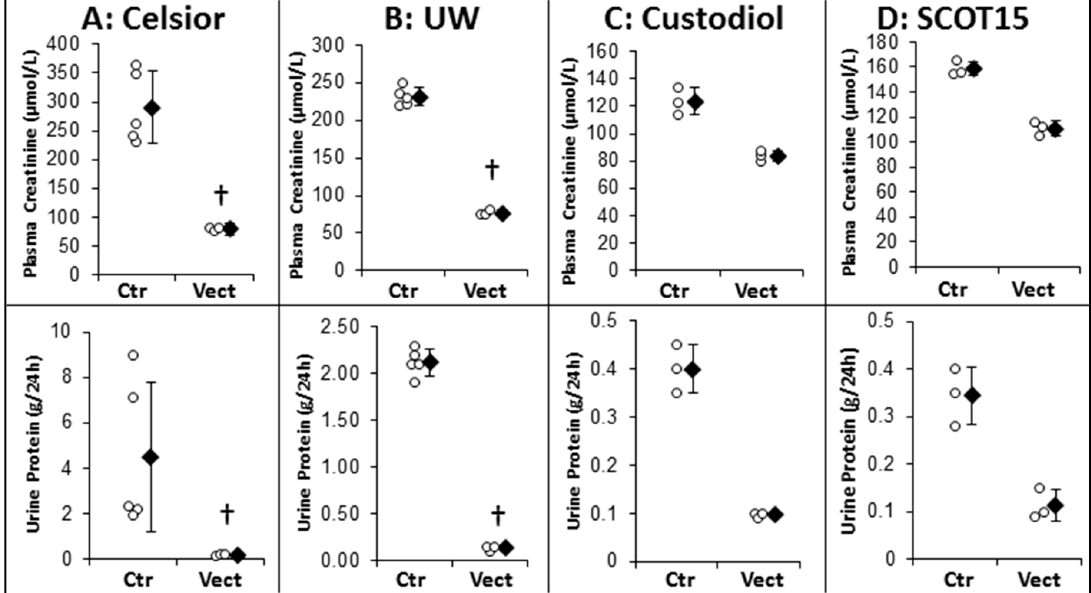
Figure 3. Evaluation of Vectisol ® benefits during static preservation: late follow-up. Vectisol was used to supplement preservation solutions in a porcine model of kidney autotransplantation. Solutions used were: ( A ) Celsior ® ; ( B ) University of Wisconsin ® (UW); ( C ) Custodiol ® ; and ( D ) Solution pour la Conservation des Organes en Transplantation (SCOT15 ® ). Pigs were euthanized after 1 month of follow-up. Shown are: Top : plasma creatinine, Bottom : urinary protein. Shown are each data point (empty dots) as well as mean ± SD (filled diamonds), statistics (Wilcoxon Test): † : p < 0.05 to